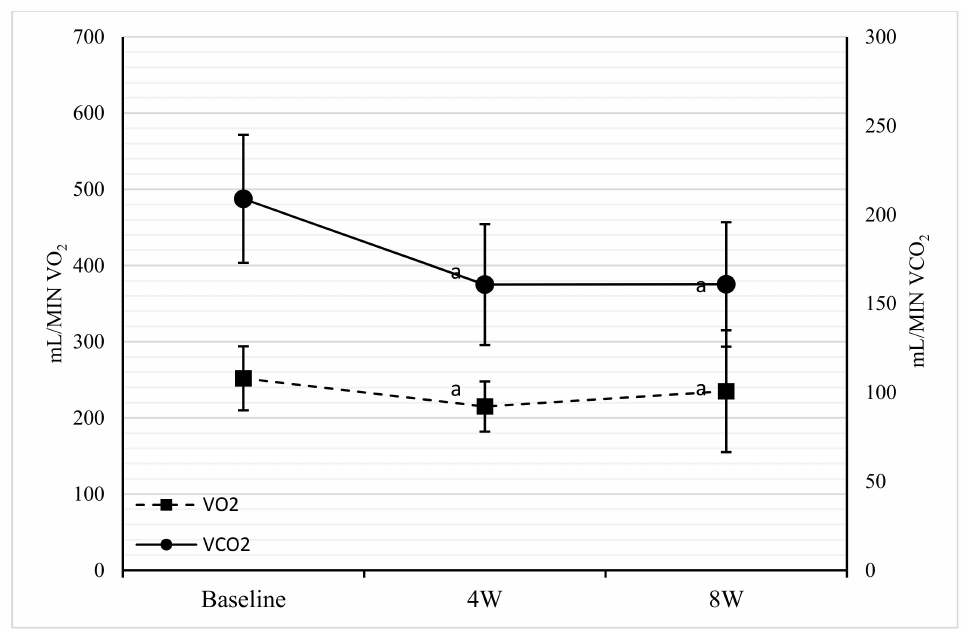
Figure 4. Comparison among baseline, four weeks, and eight weeks for VO 2 and VCO 2 . Points sharing the same superscript letter are not significantly di ff erent from each other. Statistical significance attributed to results with p < 0.05. VO 2 : Volume of Oxygen; CO 2 : Volume of Carbon Dioxide; mL / MIN: milliliter / minutes; 4W: weeks; 8W: weeks.